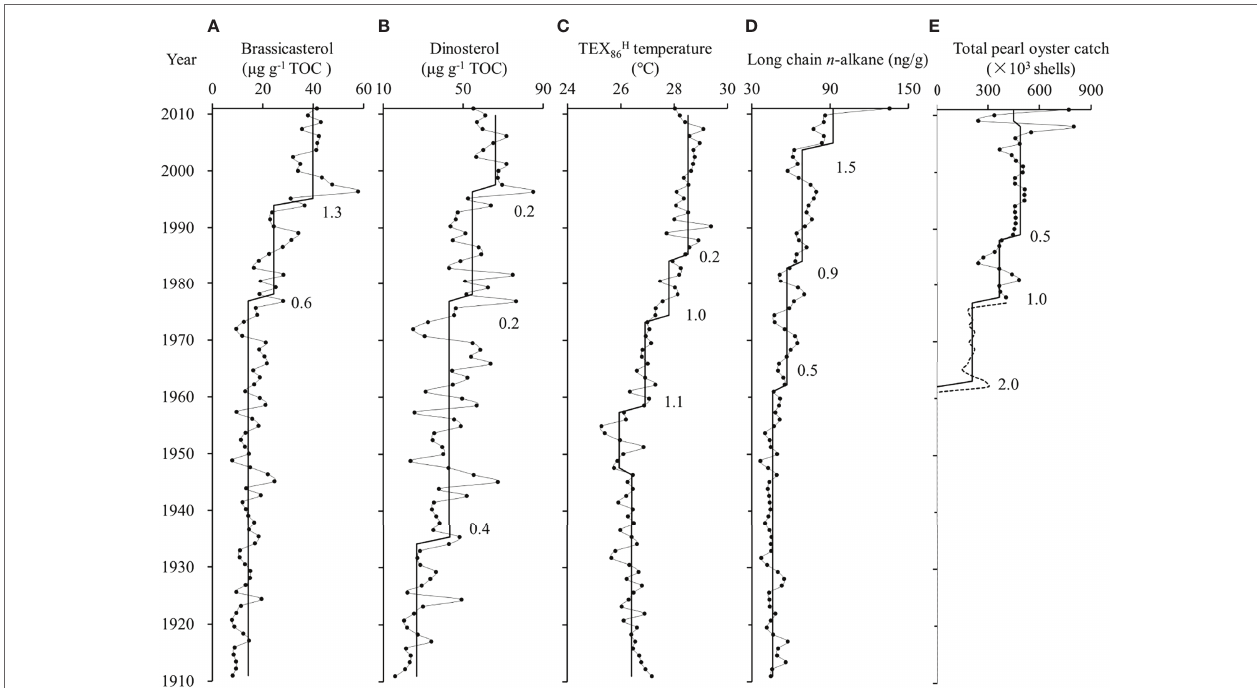
FIGURE 2 | Profiles of TOC normalized brassicasterol and dinosterol contents (A, B) , TEX 86H temperature (C) , long chain n -alkane contents (D) , and total pearl oyster catch (E) . The solid lines show shift trends assessed by sequential t test analysis of regime shift and numbers are regime shift index. Significant level is set to p < 0.05. The dashed line in total pearl oyster catch is calculated by assuming an average weight of 1 kg for each pearl